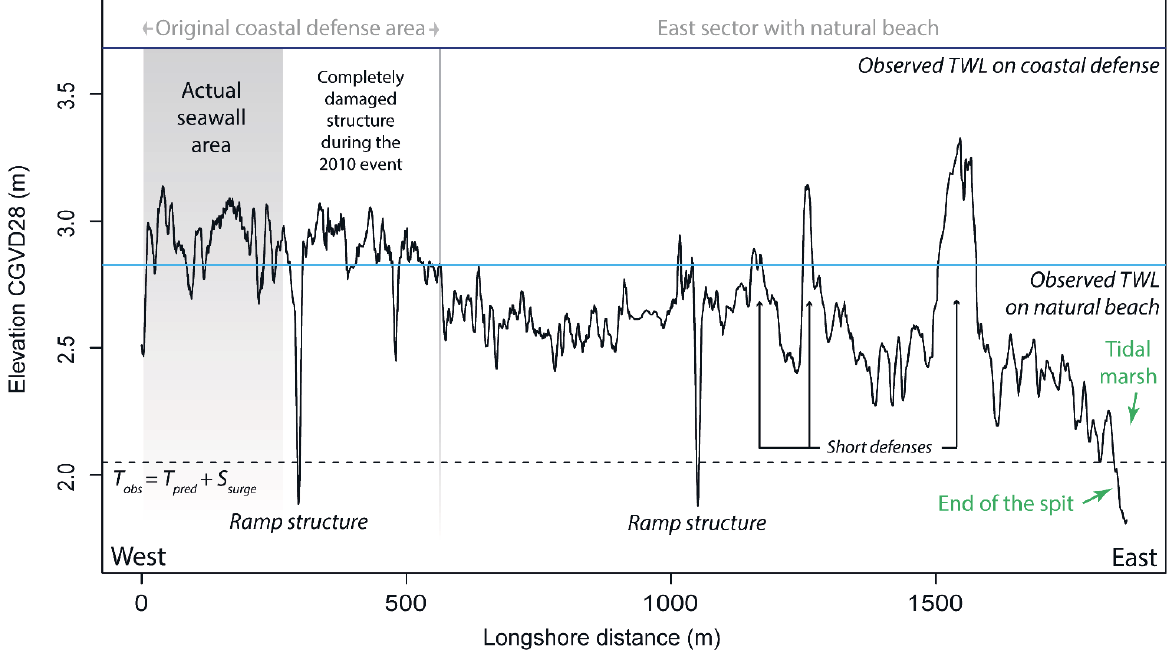
Figure 8. Recorded tide level (dashed black line) and mean observed flood limits along the coast. Longshore coastline crest elevation ( D high ) variability between the natural zone and areas with defense structures (solid black line). Observed total water levels for the defended zone (dark blue line) exceeded those for the natural areas (light blue